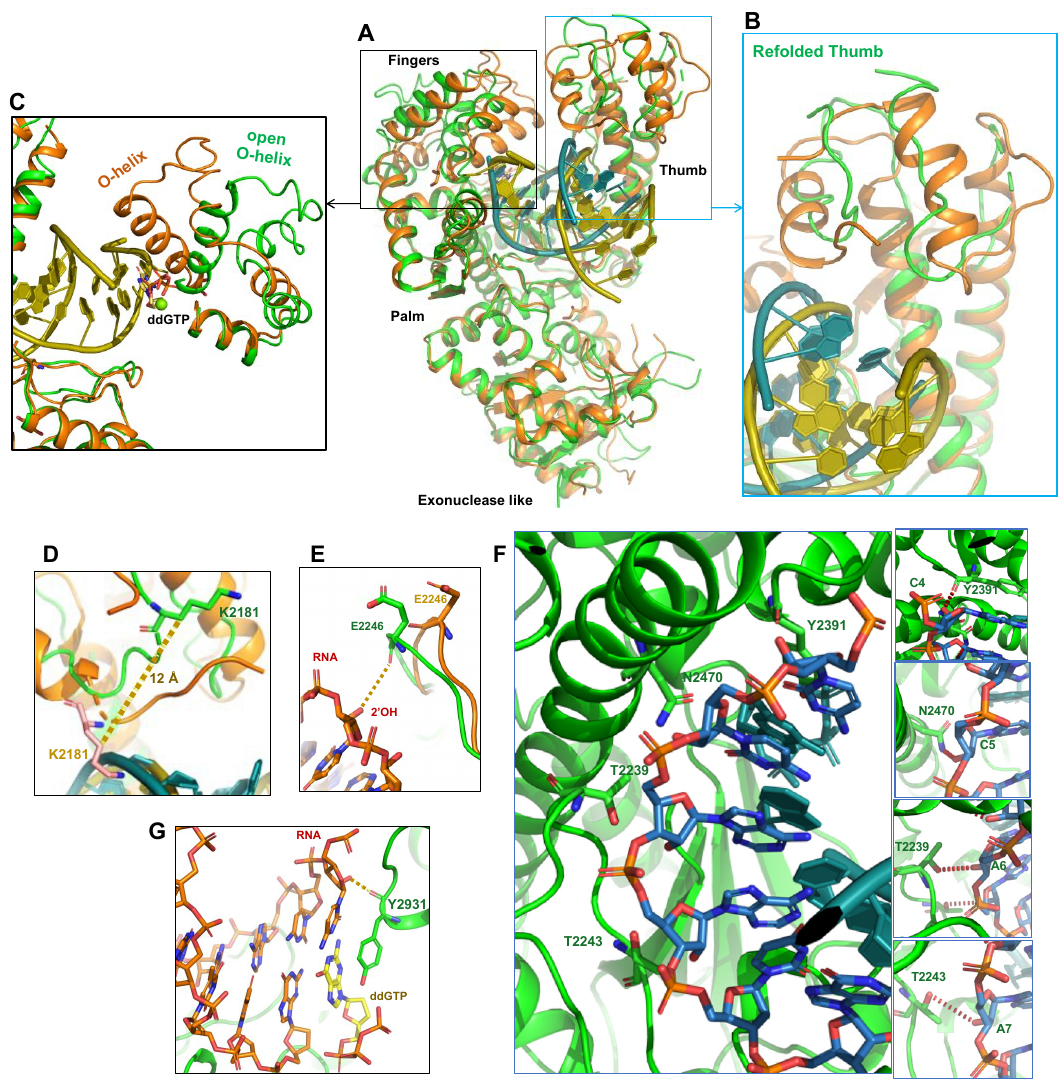
Figure 6. Structure of the Pol θ -pol:DNA/RNA:ddGTP ternary complex. ( A ) Overlap of the structures of Pol θ - pol:DNA/RNA:ddGTP (green) and Pol θ -pol:DNA/DNA:ddGTP (orange, PDB: 4 × 0 q). The fingers and thumb domains (boxed in black and blue) differ in the two structures. ( B ) The thumb domain of Pol θ -pol in the DNA/DNA has typical α -helix folding (orange), but the helices of the thumb of Pol θ -pol in complex with DNA/RNA is partially re-folded to loops (green). ( C ) The O-helix of the fingers of Pol θ -pol in complex with DNA/DNA has a closed state (orange), but the fingers of Pol θ -pol in complex with DNA/RNA have an open state (in green). ( D ) The conformational shift of K2181 of the thumb domain between the closed Pol θ -pol:DNA/DNA and the open Pol θ -pol:DNA/RNA structures. ( E ) In the Pol θ -pol:DNA/RNA structure, E2246 forms a hydrogen bond with the 2 ′ -OH of the RNA template. ( F ) Additional hydrogen bond interactions between 2 ′ -OH groups of the RNA template and Pol θ -pol residues. Zoomed-in images of these bonding interactions are shown on the left. ( G ) The main-chain carbonyl of Y2931 in Pol θ -pol forms a hydrogen bond with the 2 ′ - OH of the template ribonucleotide that pairs with the incoming ddGTP site in the active.